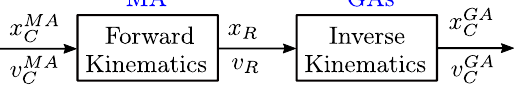
Figure 4: Reach arms motion reference conversion.